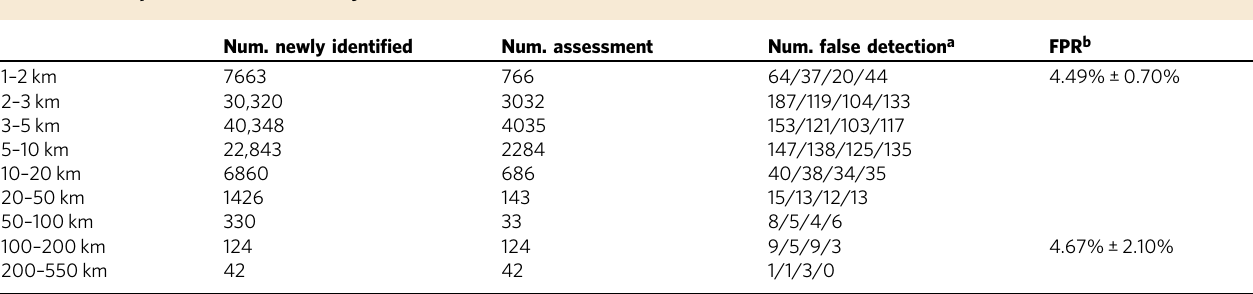
Table 2 False-positive rates of newly identi fi ed